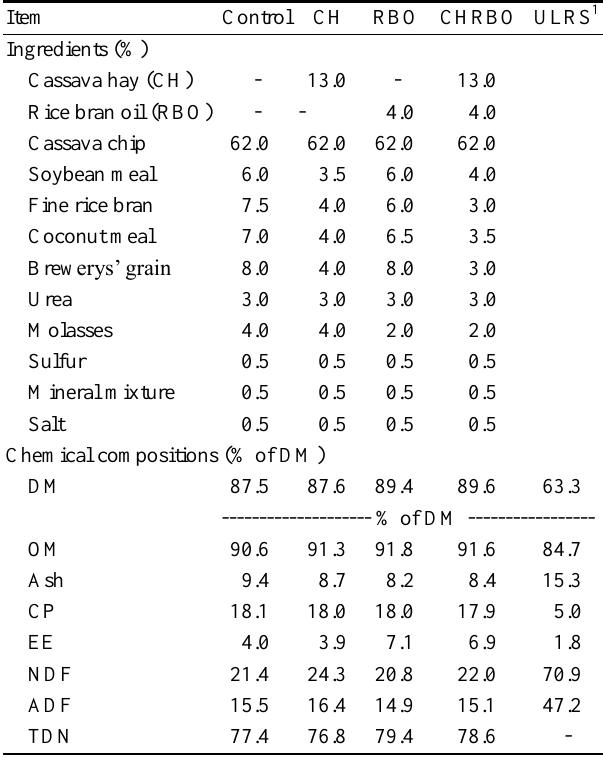
Table 1. Feed ingredients and chemical composition used in the experimental diets Item Control